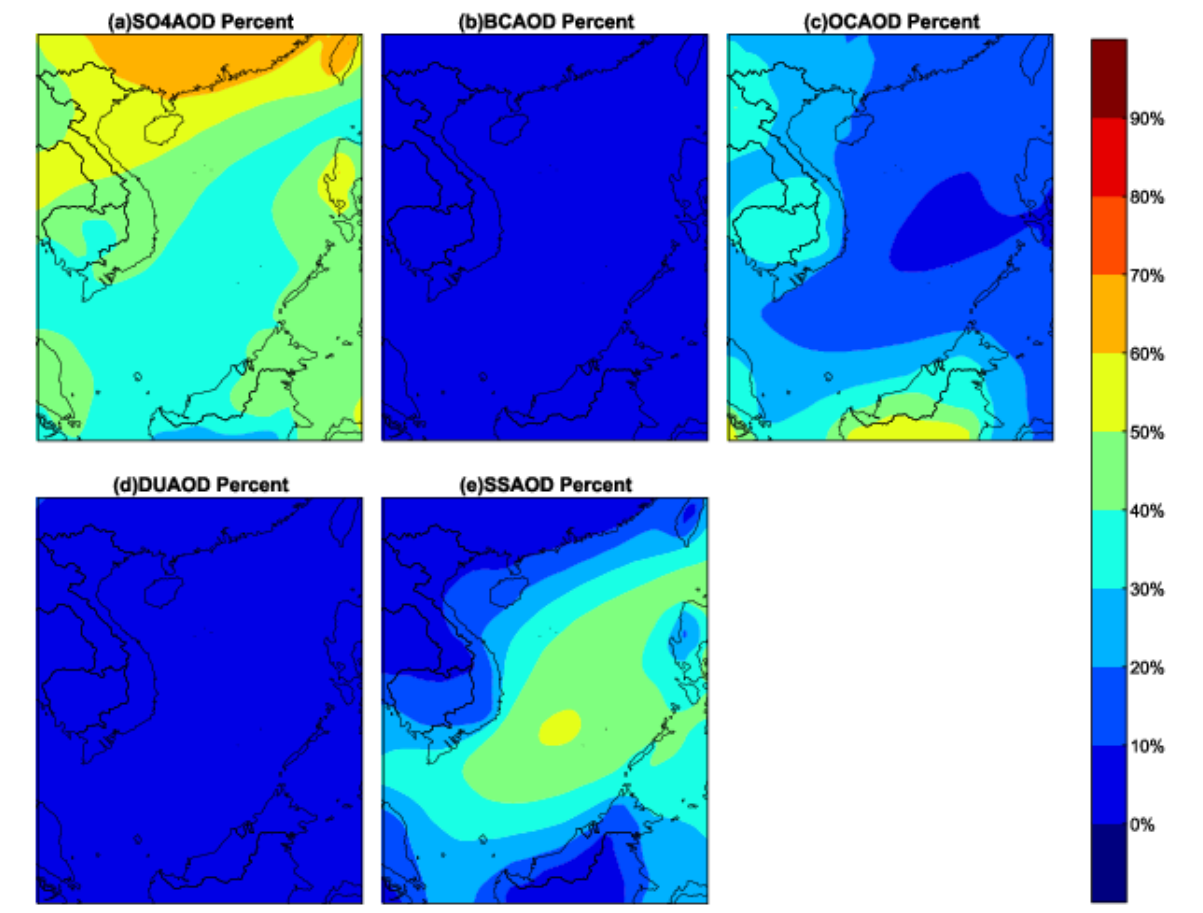
Figure 7. Spatial distribution of ( a ) SO 4 AOD Percent, ( b ) BCAOD Percent, ( c ) OCAOD Percent, ( d ) DUAOD Percent, and ( e ) SSAOD Percent over the SCS during the period of 1980–2020.